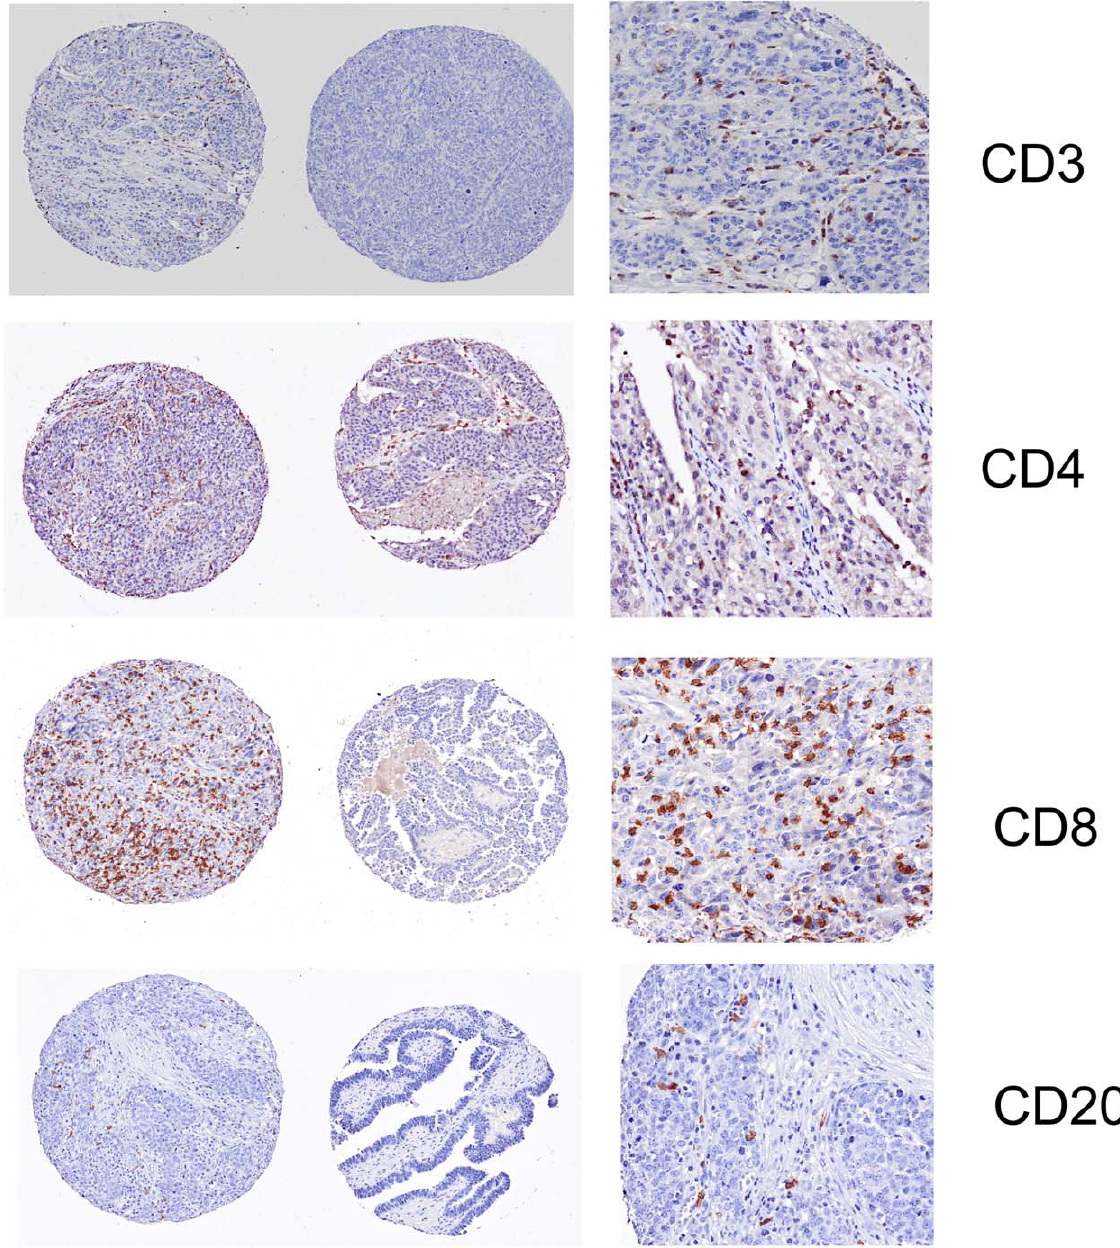
Figure 3. Representative staining for immunohistochemistry of tumor infiltrating lymphocytes. High and low density of CD3 + (T cells), CD4 + (T cells), CD8 + (T cells) and CD20 + (B cells) shown in left and middle panels. A magnification in the high infiltration area is shown on the right panel for each staining.